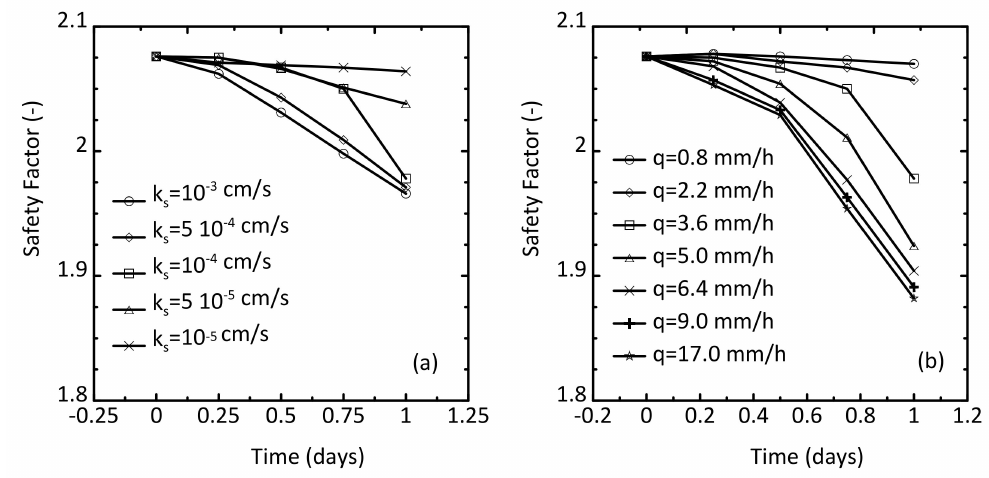
Figure 11. Slope safety factor variation with rainfall time duration, for various values of ( a ) k s and ( b )